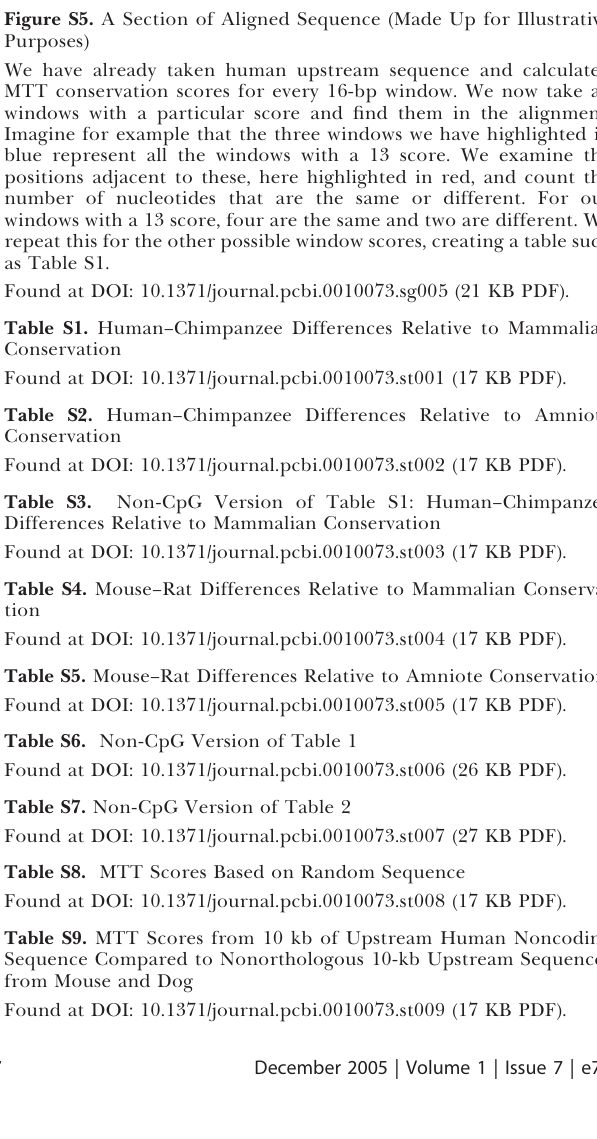
Figure S1. Results of a Simulation Illustrating Our Method Applied to Truly Random Substitutions Unlike the plots in Figure 1, this plot is flat, i.e., divergence values next to windows with a 16 score are not different from those next to windows with 10 scores. This shows that our method is not biased (see Materials and Methods for details of the simulation). Found at DOI: 10.1371/journal.pcbi.0010073.sg001 (21 KB PDF). Figure S2. Plots of Proportions As in Figure 1 (A) Data for our full set of 5,547 genes plotted along with those for a stringent ‘‘ no gene ’’ set of 2,390 genes. For this set we used more